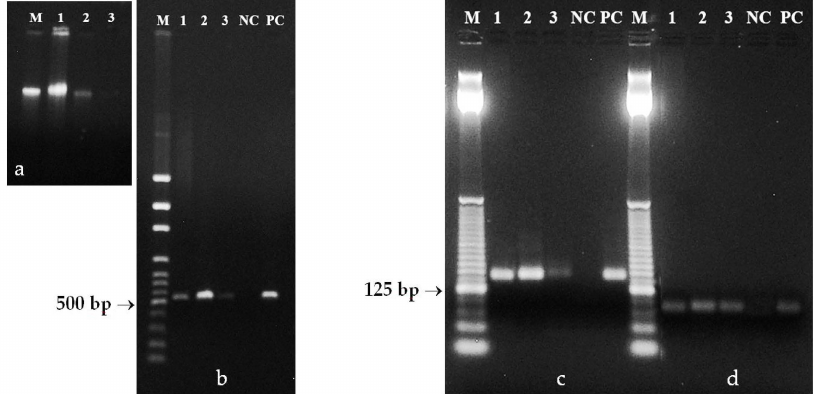
Figure 4. Genomic DNA extracted from opium poppy pollen grains ( a ). Amplification of 553 bp ( b ) and 96 bp ( d ) fragments of reference tubulin gene, and 156 bp ( c ) microsatellite, respectively.